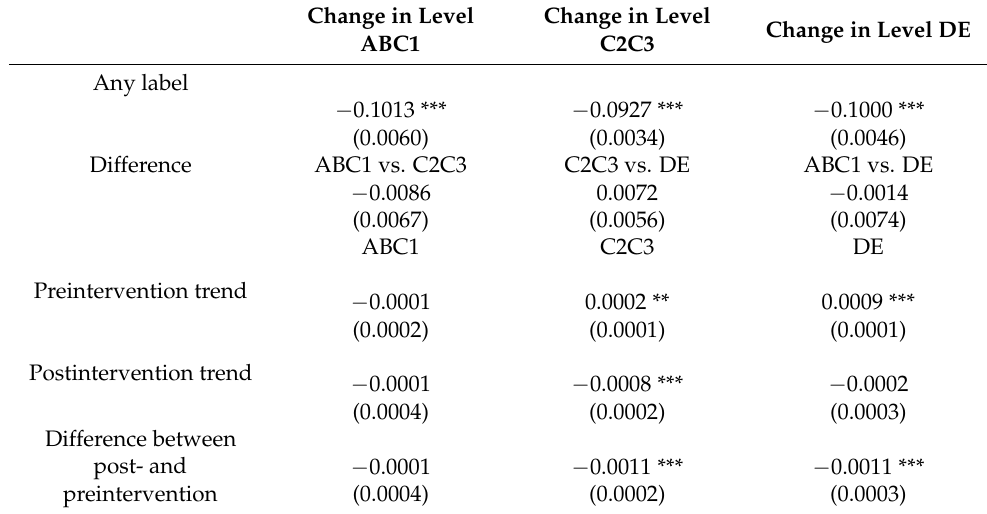
Table 4. Marginal effects on the budget shares and trends before and after the intervention by SES